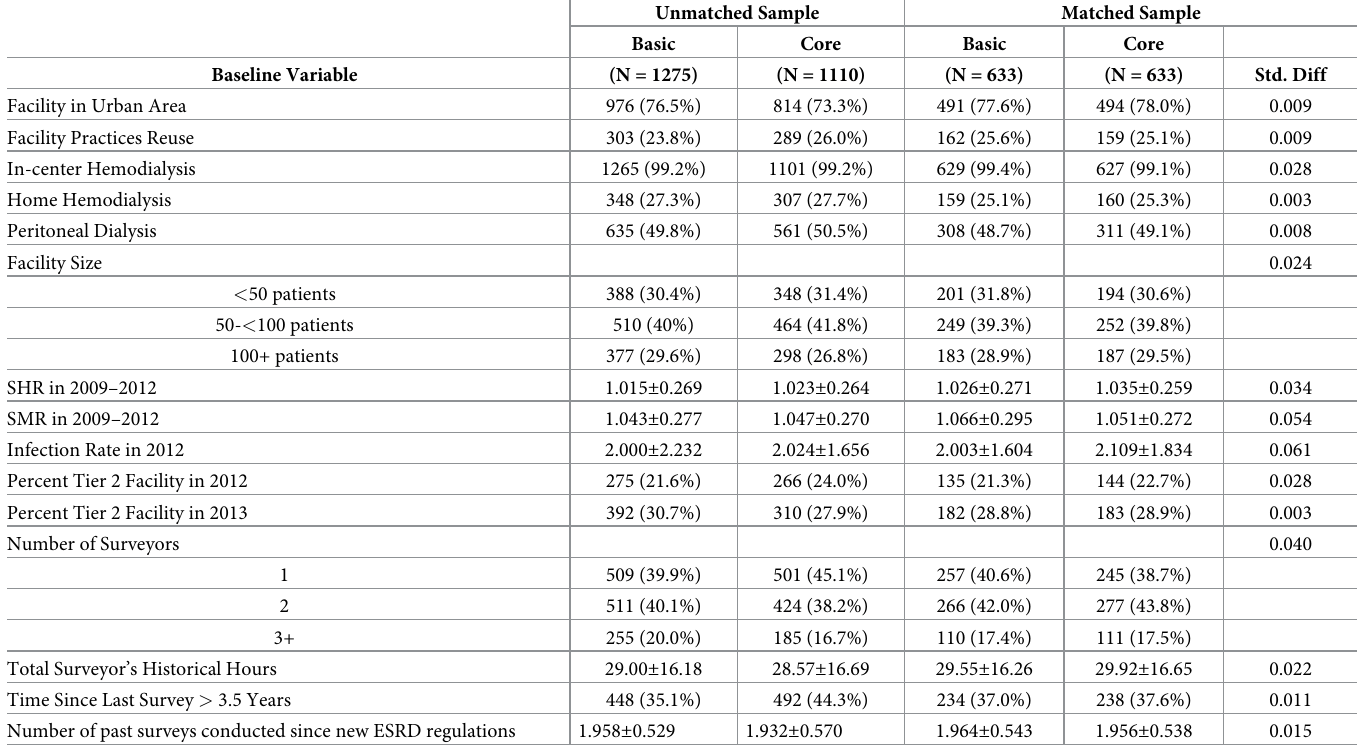
Table 1. Comparison of baseline characteristics between Basic and Core surveys in the unmatched and matched samples. Std. Diff, Standard difference. Continuous variables are reported as mean ± standard deviation. Categorical variables are reported as number